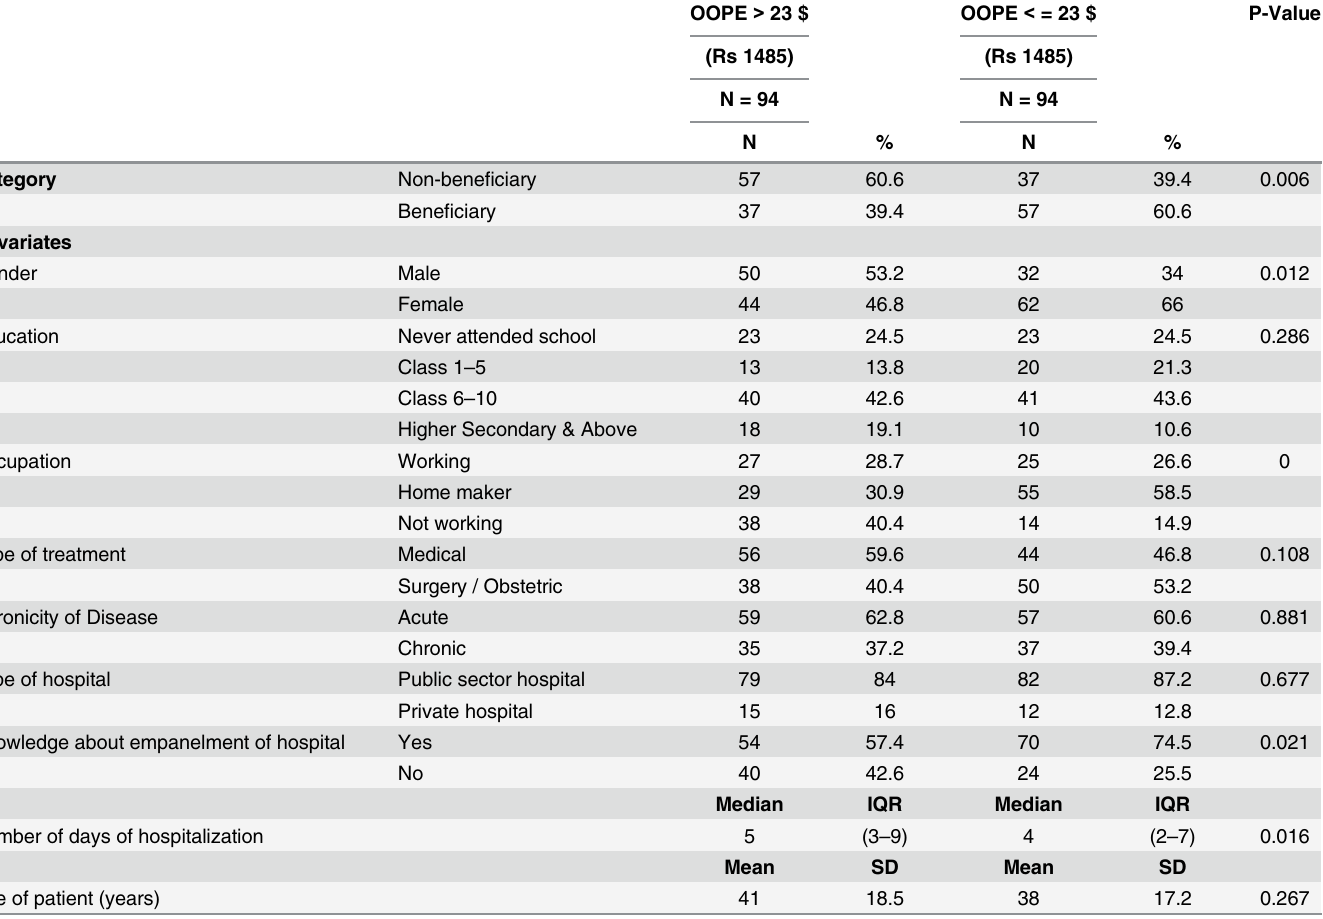
Table 5. Beneficiary/non beneficiary status and other covariates according to the outcome variable median out of pocket expenditure (OOPE), Solan, Himachal Pradesh, India, 2013.